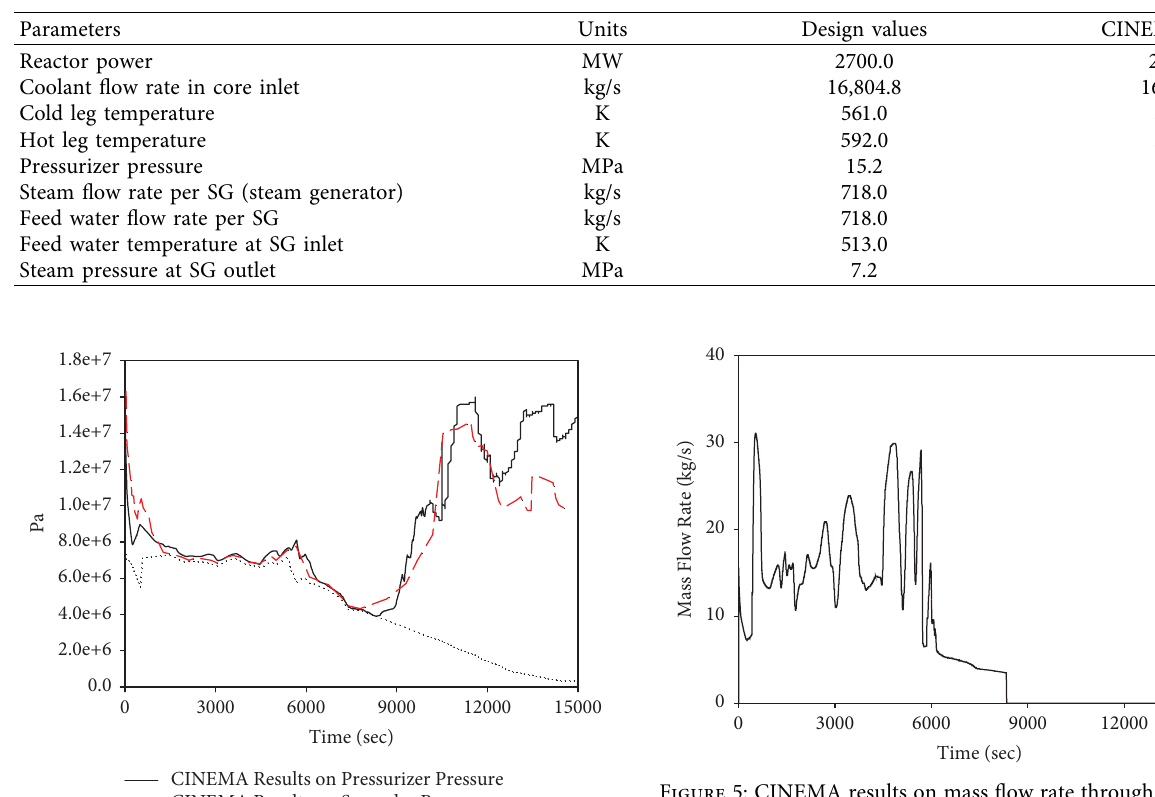
Table 2: Comparison of CINEMA results with the TMI-2 operating condition.